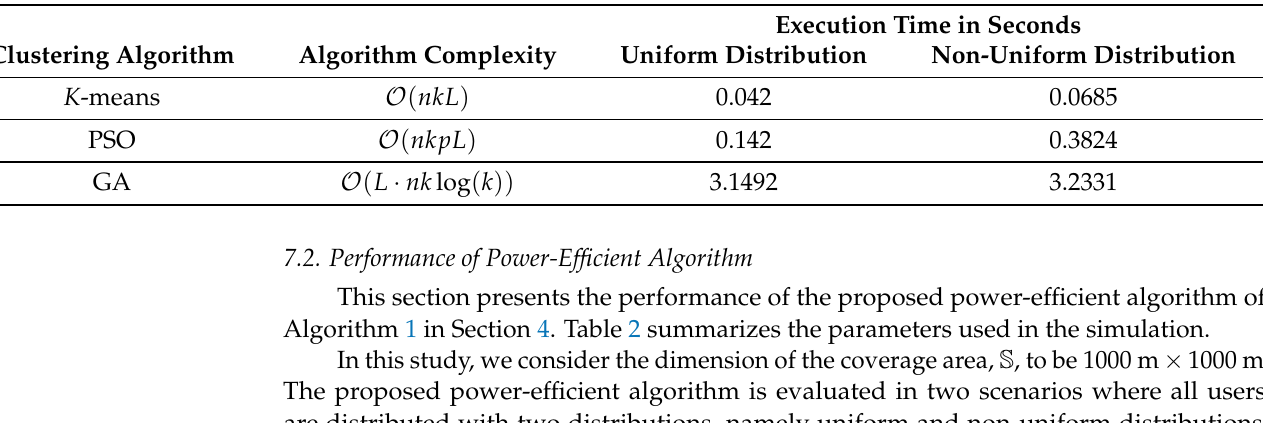
Table 1. Execution time for clustering algorithms to partition uniformly distributed